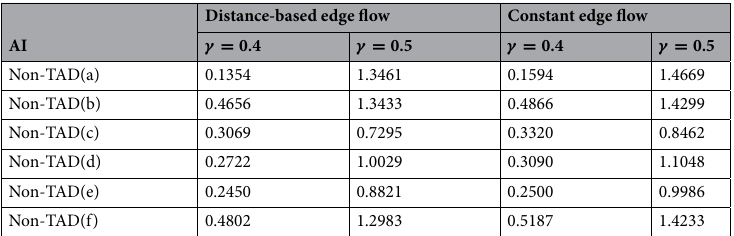
Table 3. HodgeRank-based analysis on regions that are non-TADs. By non-TADs, we refer to the regions where contact frequencies are less or the regions where TADs are mostly not part of the region. The AI values are used for the quantitative measurement of the folding within non-TAD regions. Generally, low AI values were recorded due to the region having less contact frequency as compared to the AI values of TADs. Two different edge flow models, i.e., distance-based edge flow and constant edge flow, are considered. Two different cutoff distances, i.e., γ = 0.4 and γ = 0.5 , are used to construct Hi-C matrix-based simplicial complexes. Here non-TAD(a) to non-TAD(f) are non-TAD regions as illustrated in Fig. 10a–f, respectively.